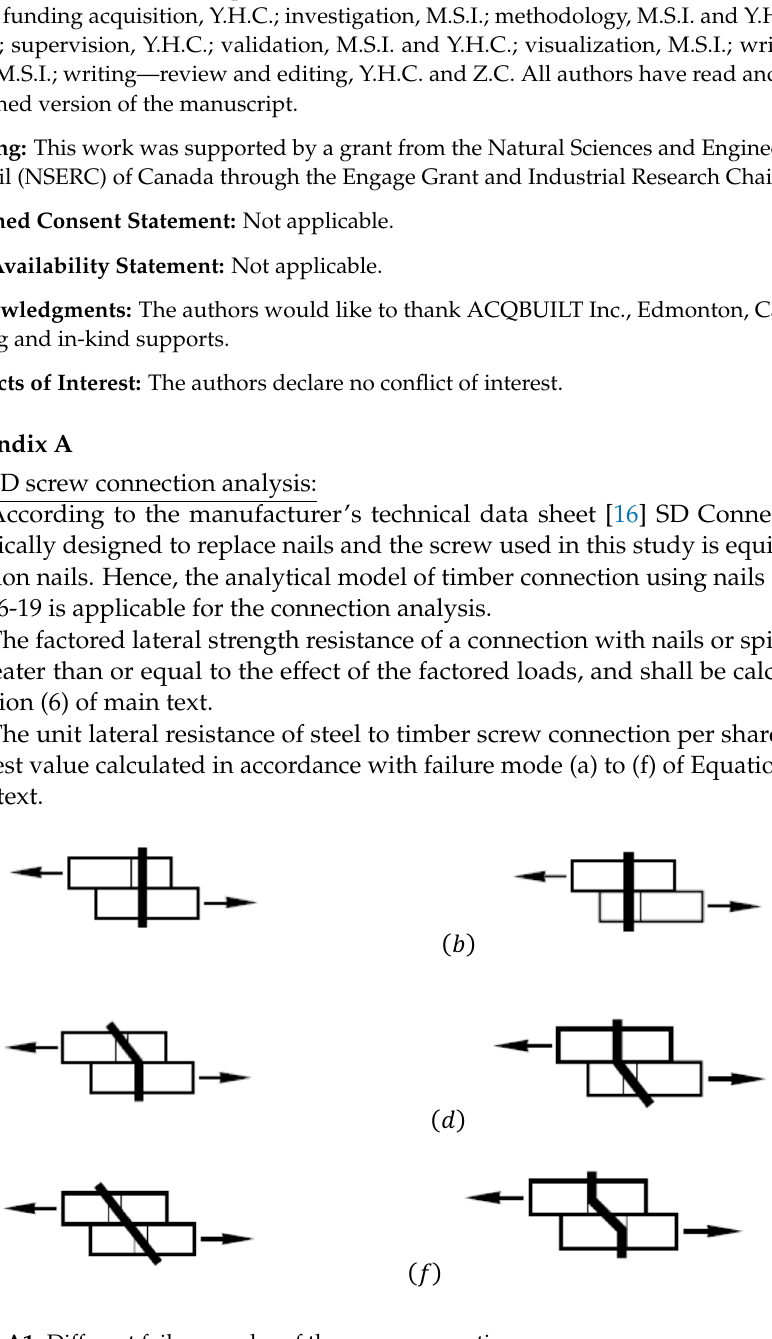
Figure A1: Different failure modes of the screw connection. Figure A1. Different failure modes of the screw